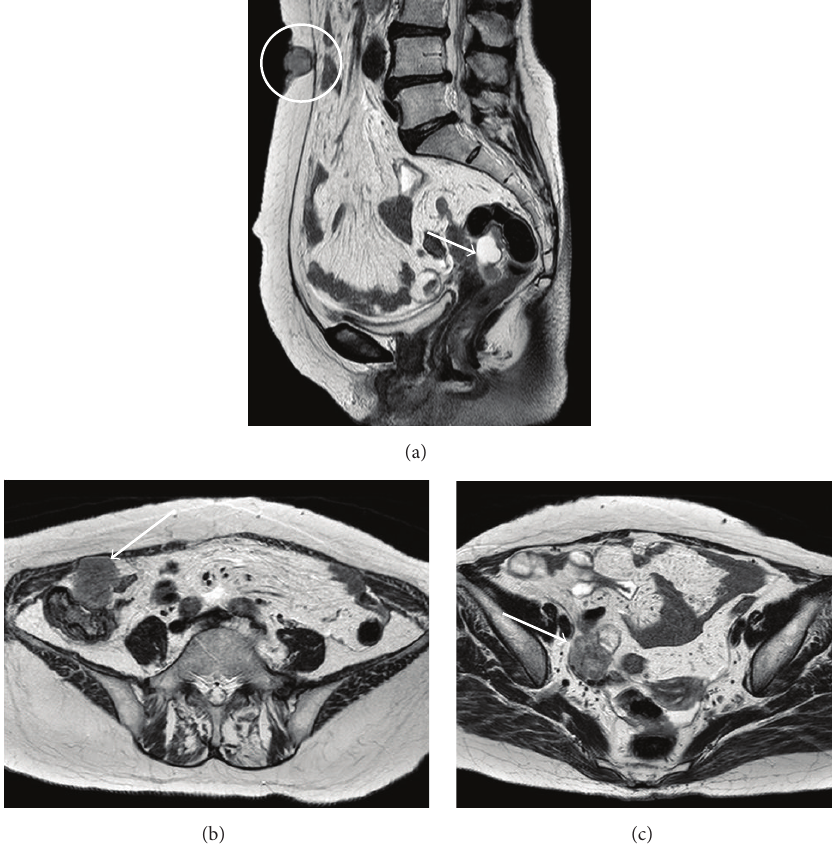
Figure 2: MRI images showed tumors in the ovary (a, → ) and umbilicus (a, circle). Also intra-abdominal nodular lesions were noticed (b, c →